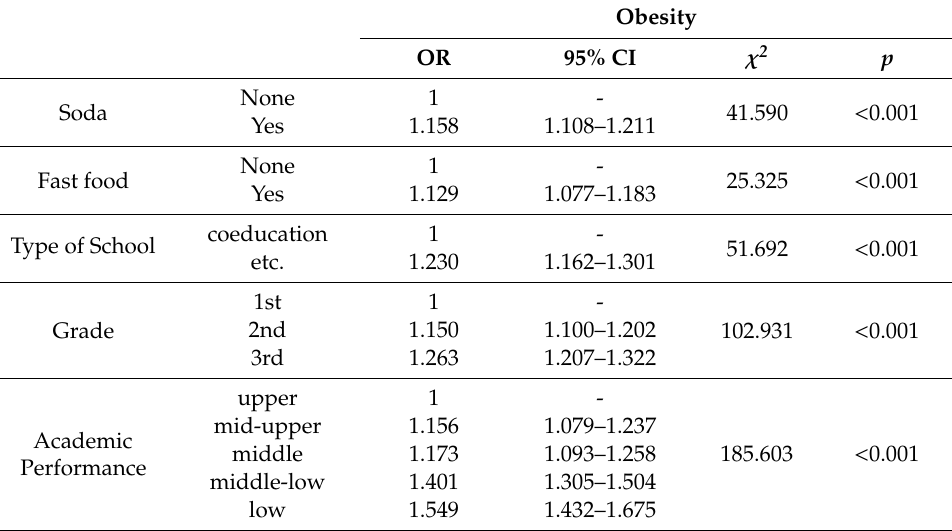
Table 5. Odds ratio between childhood obesity and influencing